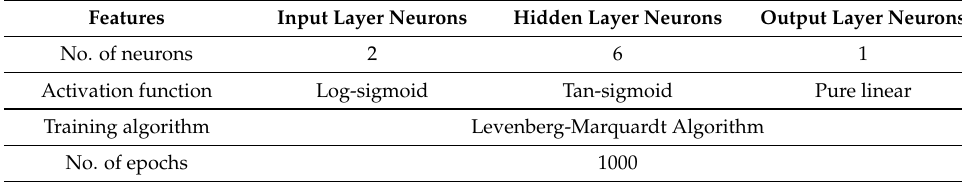
Figure 5. Frequency deviation after load and generation changes for different n p values. Table 1. Proposed artificial neural network (ANN)